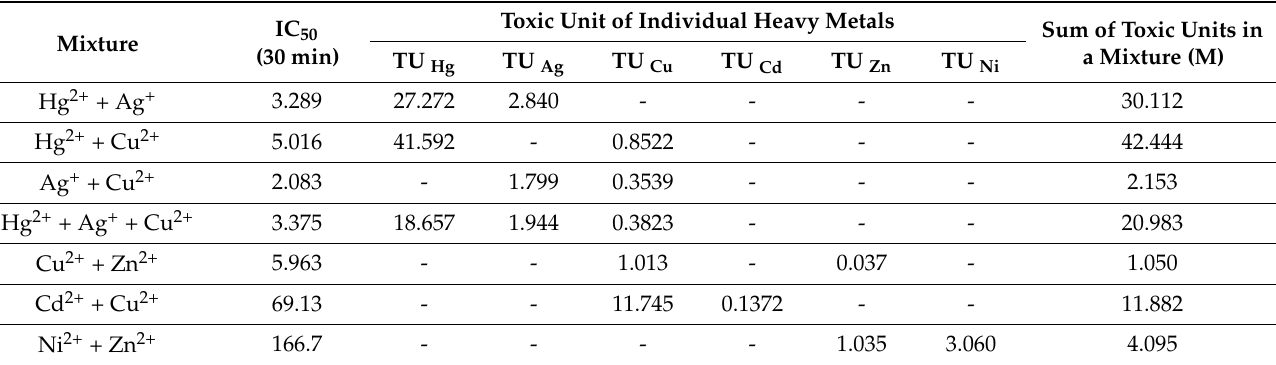
Table 4. List of Toxic Unit (TU) for each heavy metals tested acutely and a total of the toxic units in two and three joint mixtures of heavy metals on Photobacterium sp.NAA-MIE.